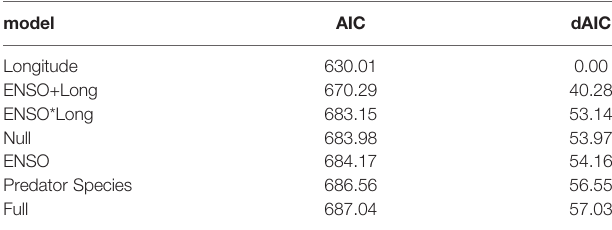
TABLE 5 | Generalised linear model analyses used to explain differences in prey species composition (Family level) identi fi ed using conventional morphological